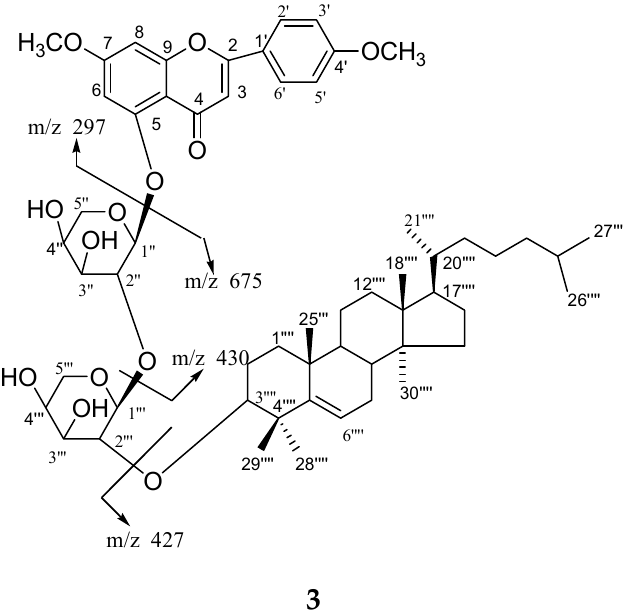
Figure 4. Fragmentation patterns of compounds 1 – 3 .